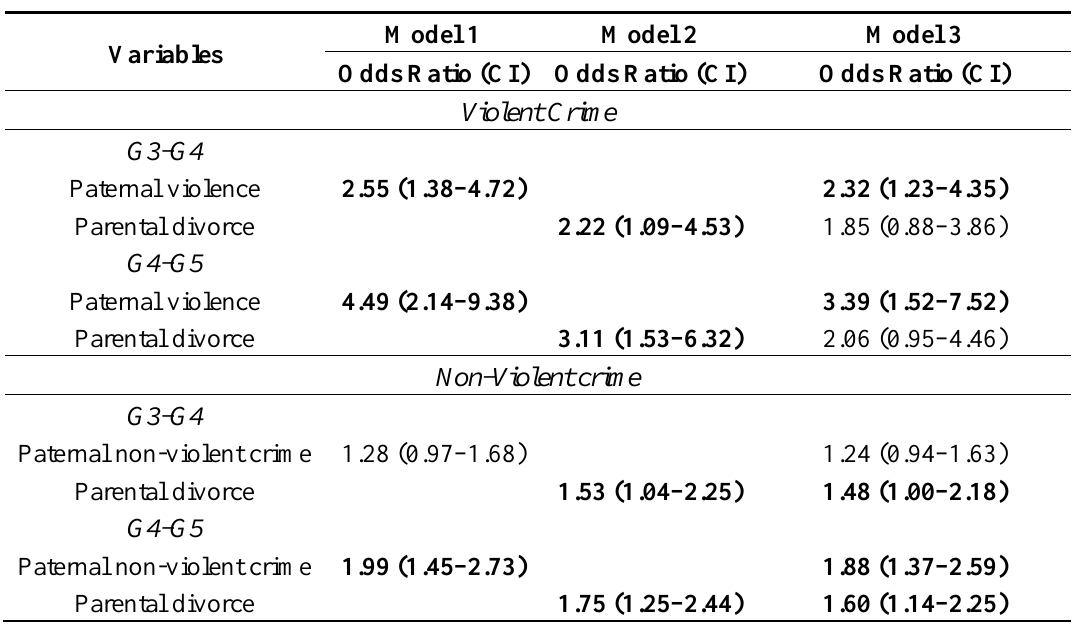
Table 2. Generalized estimation equation (GEE) models for the impact of paternal crime and parental divorce on offspring